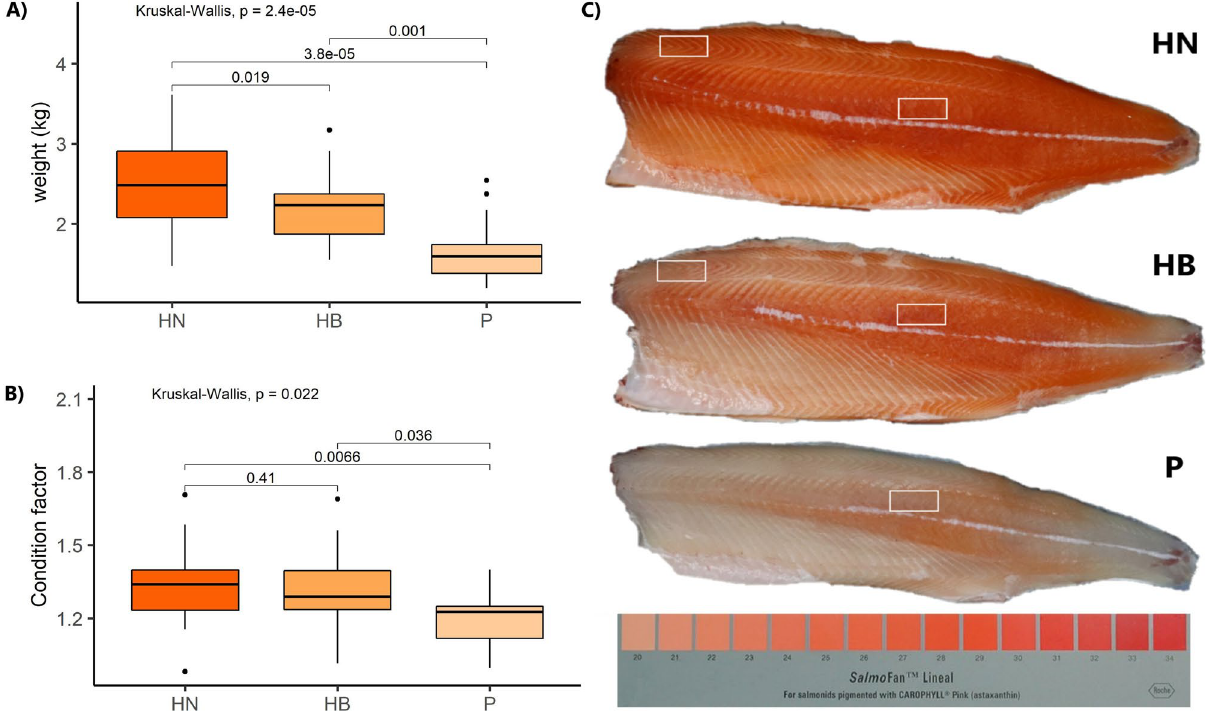
Figure 1. Weight ( A ) and condition factor ( B ) of fish associates with flesh phenotype. HN: High red color-no banding, HB: High red color-banded, P: pale (n = 39 for HN, n = 25 for HB fish and n = 13 for pale fish). Significant differences were determined by one-way ANOVA ( P ≤ 0.05). ( C ) The grouping of experimental fish based on flesh color. FD (front dorsal) and BC (back central) regions sampled are marked by white squares. The classification of flesh color phenotypes is based on a score measured using SalmoFan™ Lineal in the front dorsal and back central regions: High red color-no banding (HN) fish, High red color-banded (HB) fish, Pale (P) or transitional between HN and Pale fish, displaying atrophied MFs and expanded interstitial spaces (Fig. 3D). MF diameter in HB fish was similar to HN fish ( P > 0.05) but significantly larger than Pale fish ( P < 0.01). The interstitial spaces in HB fish were not significantly different from either HN or Pale fish ( P > 0.05). When com- paring HN and HB with Pale fish, the latter had significantly larger interstitial spaces, with most of the MF being atrophied (Fig. 3F).